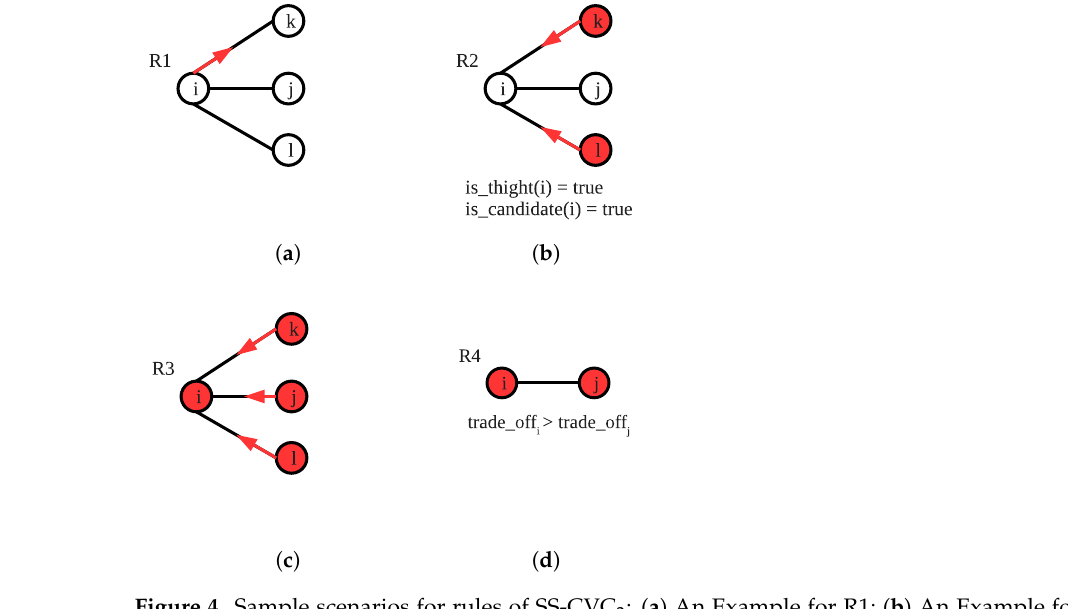
Figure 4. Sample scenarios for rules of SS-CVC 2 : ( a ) An Example for R1; ( b ) An Example for R2; ( c ) An Example for R3; ( d ) An Example for R4.